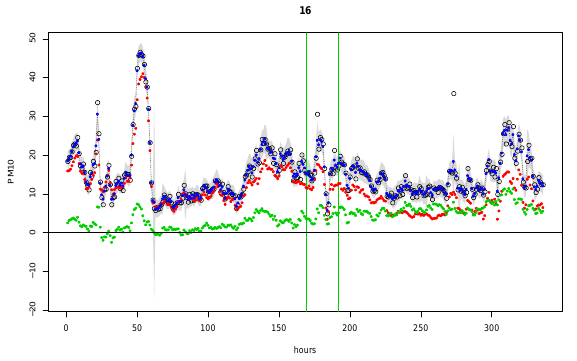
Figure 4. Predictions of PM10 at Airbox 16. Included are the 95% prediction interval (grey region), median β t (red dots), me- dian u t ( s 9 ) (green dots), median prediction (i.e., β t + u t ( s 9 ) ) (blue dots), observed value (open black circles).